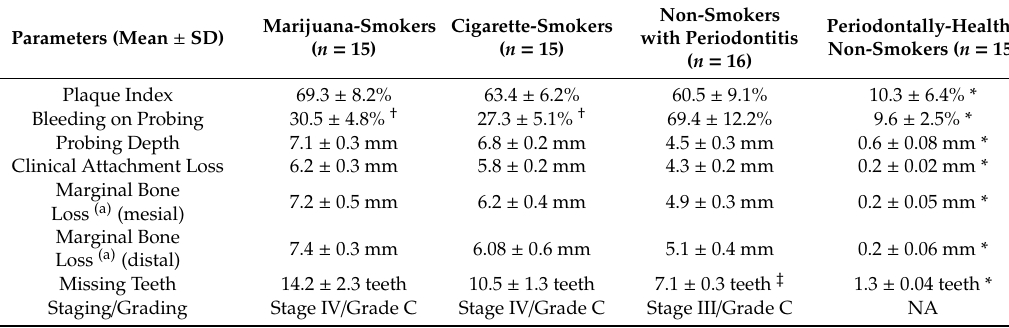
Table 2. Clinicoradiographic parameters and staging / grading of